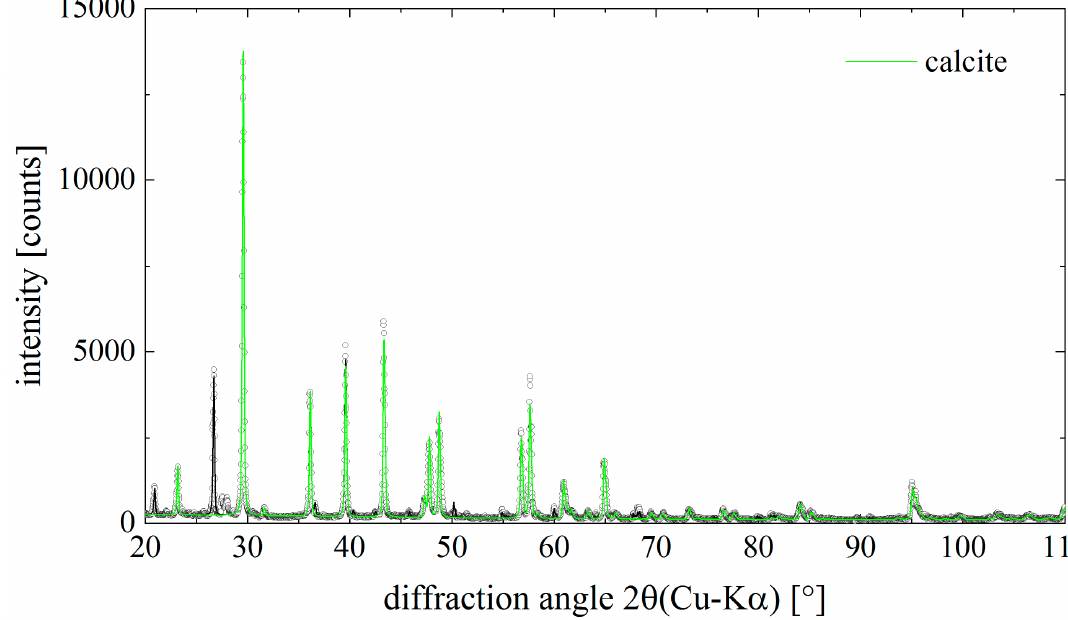
Figure 6. Diffraction pattern of the mineral phase isolated from chitinous skeletal fibers of I. basta demosponge. Dots are measured data points, the solid lines result from a Rietveld- (Pawley)-fit of the data. The contribution of calcite to the total diffraction pattern is highlighted in green color. Calcite is the main component in the